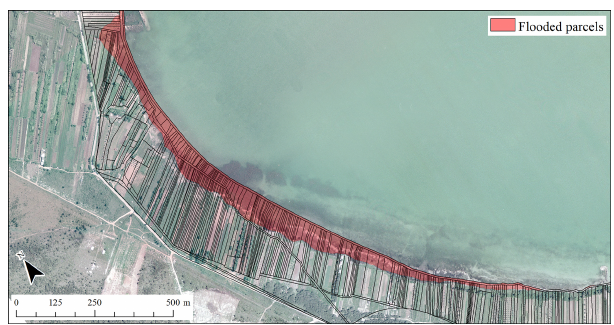
Figure 12. Flooded agricultural parcels in the Pakoštane cadastre at a water level of 2m (northwestern section of the park).